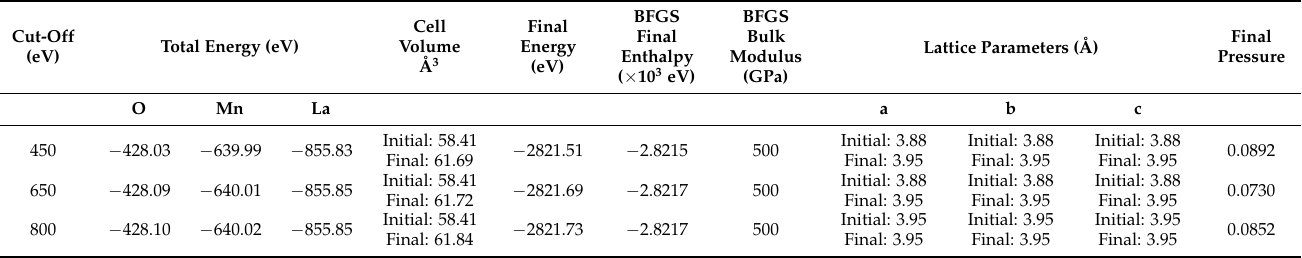
Table 6. Data of theoretical calculations using the CASTEP module with the Pm-3m space group.